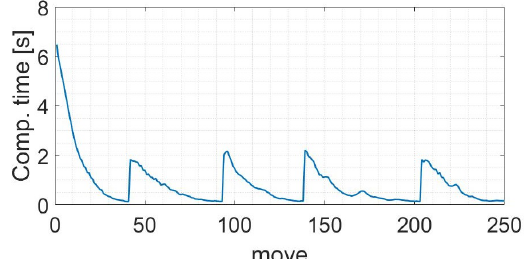
Figure 12. The computational time required to perform the most complex simulation, i.e., with a fleet of 10 UAVs in the Field 4. Excluding the initialization phase, the computational time varies between 2 s and 0.1